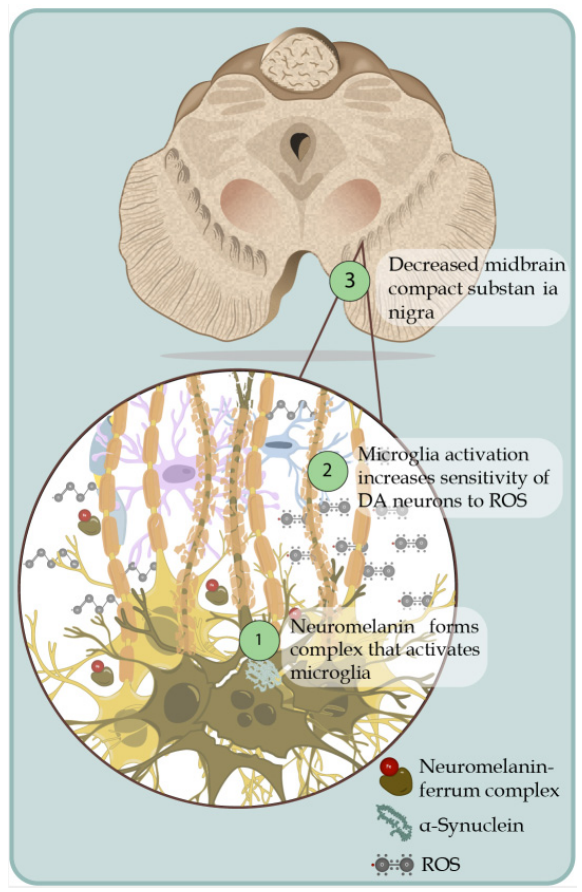
Figure 1. Death of dopaminergic neurons. Schematic representation of dopaminergic neuronal death associated with the generation of ROS in an uncontrolled way. 1. The pigment that gives color to dopaminergic cells is due to the oxidation of cysteinyl-DA prod- ucts (dopamine that is not adequately removed works as ROS-generating molecules), products that interact with Fe+ forming a complex that activates the microglia and thereby generates the produc- tion of pro-in fl ammatory cytokines and the production of ROS, which induce the formation of al- pha-synuclein fi brils. 2. Activation of microglia by the release of neuromelanin from pars compacta causes an increase in the sensitivity of dopaminergic neurons to oxidative stress; the dopaminergic neurons of the com- pact substantia nigra are more susceptible to ROS, which is why they more easily cause the death of this neuronal subpopulation in areas such as nuclei A9. 3. Decreased midbrain compact substantia nigra. Histopathologically, PD is primarily characterized by abnormal accumulation and deposition of aggregated alpha-synuclein in dopaminergic neurons of the central nervous system (CNS) in the form of intracellular inclusions, the “Lewy bodies”. This leads to a loss of dopaminergic neurons at the level of the substantia nigra, and, incidentally, to a lack of dopamine in the putamen and the caudate nucleus (striatum).